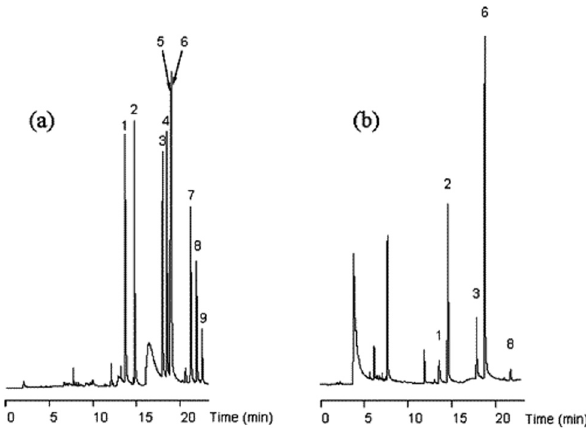
Figure 6: Gas chromatograms obtained in the LVI - GC - NPD analysis of pesticide residues in ( a ) a tomato sample forti fi ed at 0.05 mg kg − 1 and ( b ) a real tomato sample. Reprinted with permission from ref.